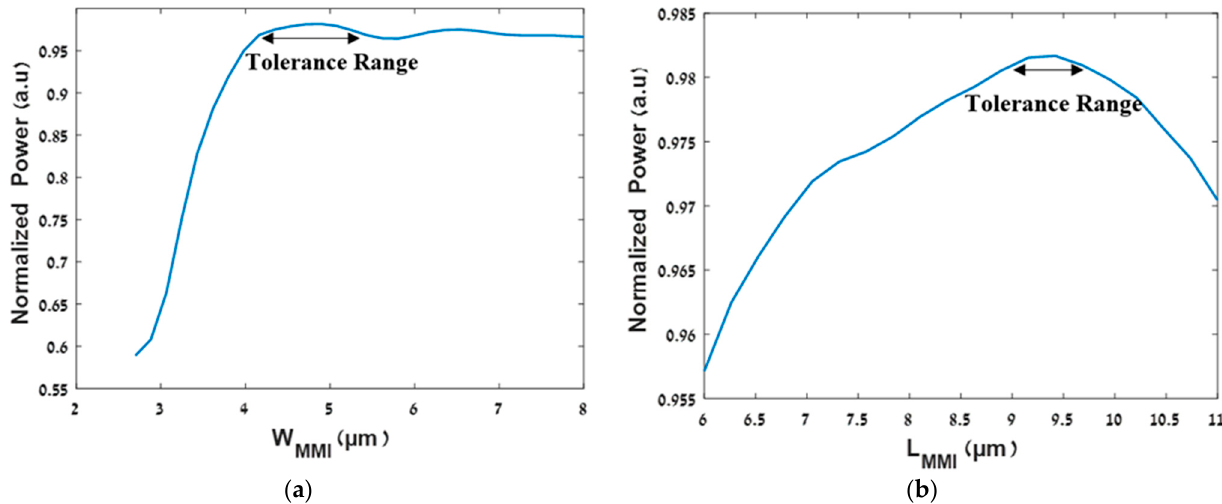
Figure 5. Optimizations of the MMI coupler geometrical parameters: ( a ) normalized power vs. W MMI; ( b ) normalized power vs. L MMI . W MMI ; ( b ) normalized power vs. L MMI .